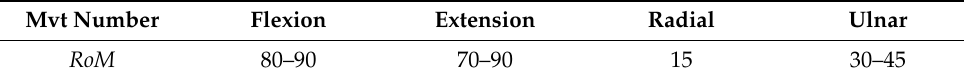
Table 2. Wrist RoM for a healthy